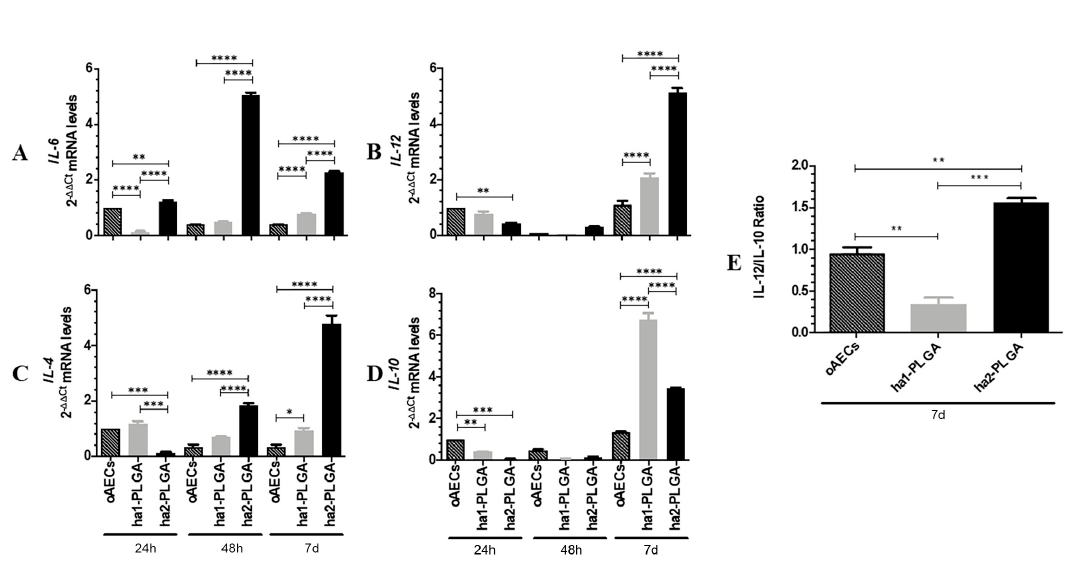
Figure 10. Anti-inflammatory and pro-inflammatory ILs expression profiles in oAECs seeded on ha1- and ha2-PLGA fleeces. ( A and B ) Pro-inflammatory IL-6 and IL-12 and ( C and D )Anti-inflammatory IL-10 and IL-4 mRNA expressions were studied in oAECs and in oAECs seeded on ha1-PLGA and on ha2-PLGA fleeces after 24 h, 48 h and 7 days of culture. oAECs after 24 h of culture on Petri dish was used as the reference sample (oAECs at 24 h = 1). ( E ) IL-12 / IL-10 ratio of the expression levels in oAECs and in oAECs seeded on ha1-PLGA and ha2-PLGA fleeces after 7 days (7 d) of culture. oAECs after 7 days of culture on Petri dish was used as the reference sample (oAECs at 7 d = 1). Relative quantification was done using the ∆∆ Ct method and GAPDH was used as the housekeeping gene. The data are mean ± SD of 3 replicates (n = 3 experimental replicates) performed in oAECs collected from at least 3 fetuses (n = 3 biological replicates). * Statistically significant among the di ff erent groups at each time point ( p < 0.05). ** Statistically significant among the di ff erent groups at each time point ( p < 0.01). *** Statistically significant among the di ff erent groups at each time point ( p < 0.001). **** Statistically significant among the di ff erent groups at each time point ( p <